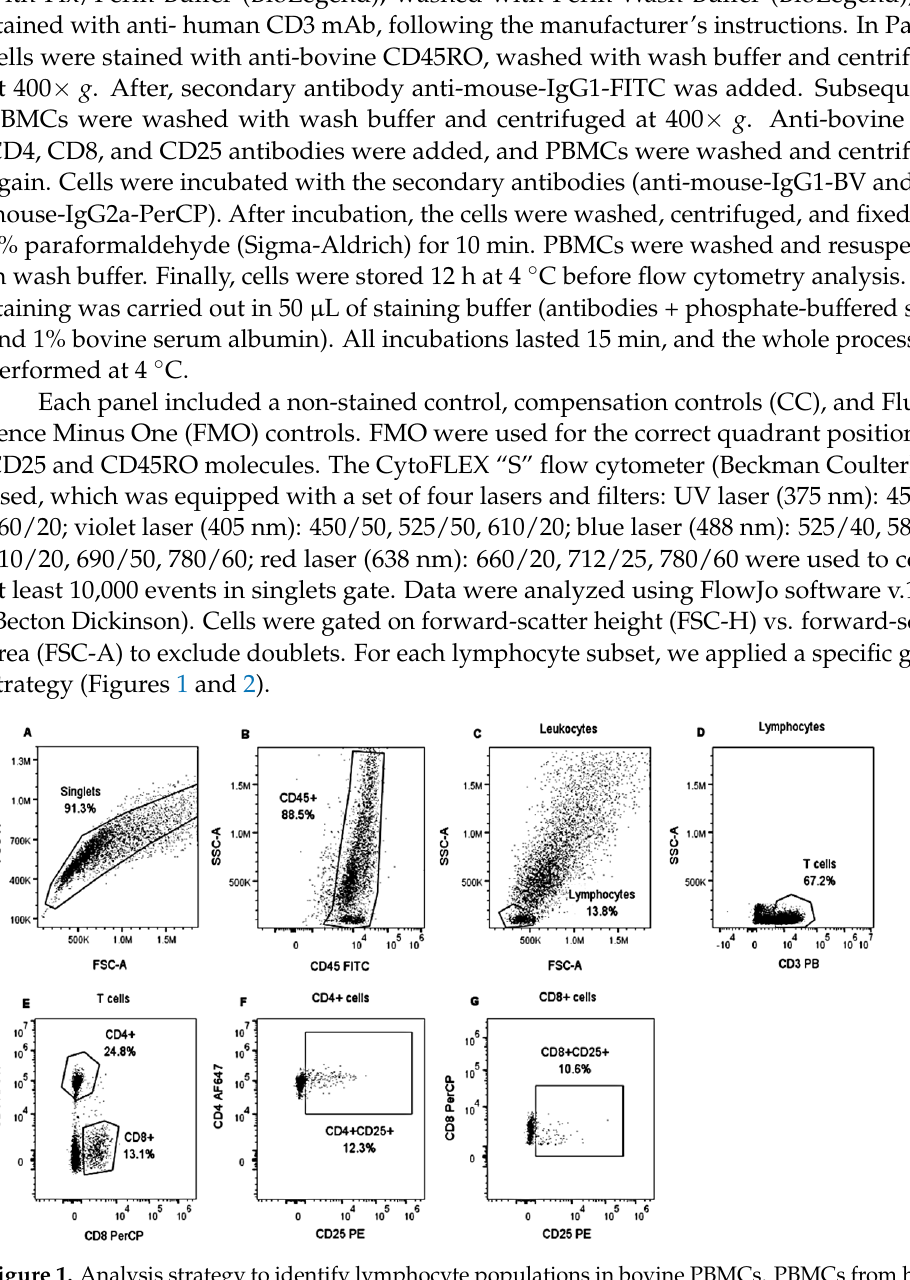
Figure 1. Analysis strategy to identify lymphocyte populations in bovine PBMCs. PBMCs from heifers positively and negatively tested for tuberculin were stimulated with CFPE and cultivated for three days. An unstimulated control was also included. Then, PBMCs were stained with Panel 1. Singlets were gated on FSC-H and FSC-A ( A ). Then, SSC gating was applied, and CD45 + expression was analyzed to visualize leukocytes ( B ). Lymphocytes were identified based on SSC and FSC properties ( C ). T lymphocytes were identified by assessing CD3 + expression ( D ). T cells were separated into two groups based on CD8 + and CD4 + expression ( E ), and CD25 + expression was analyzed in both T cell populations ( F , G ). PBMCs from a tuberculin-negative heifer stimulated with CFPE.